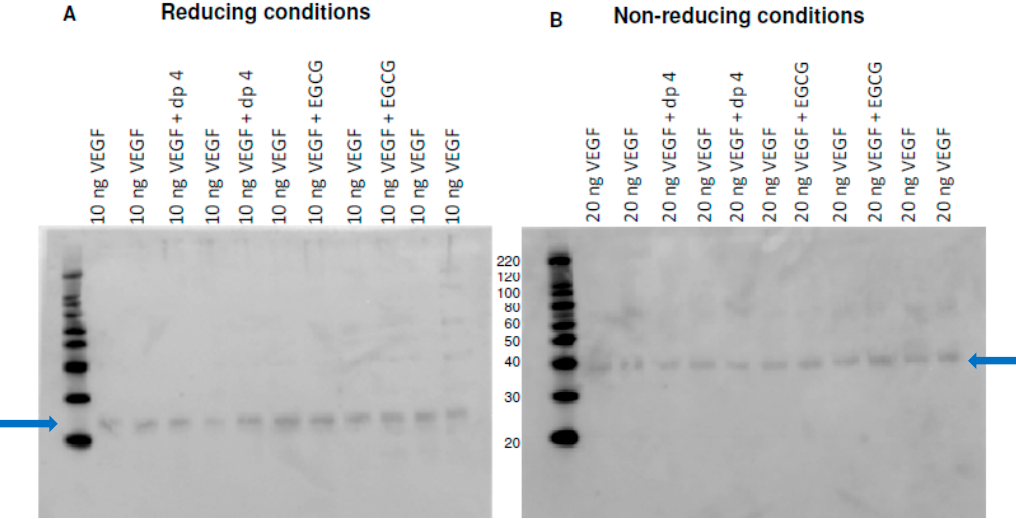
Figure 2. SDS-page gels of control (VEGF) and treatments (VEGF and apple procyanidin fraction dp4 or EGCG under ( A ) reducing conditions and ( B ) Non-reducing conditions.